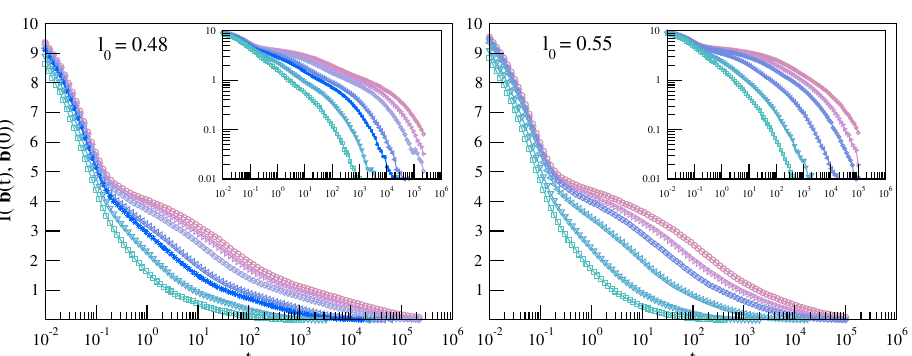
Figure 10. Temperature dependence of the MI correlation loss between the bond orientations at t 0 and t 0 + t of the chains with different bond lengths. The color codes are as in Figure 9.